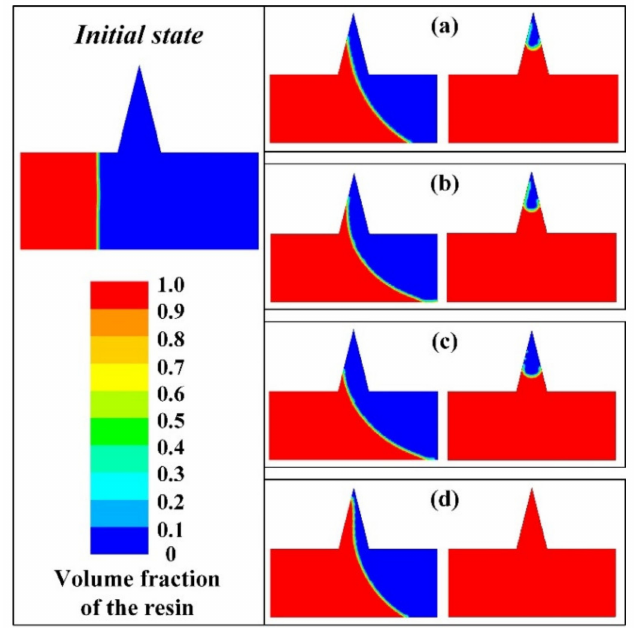
Figure 12. The filling evolution process with different slip positions ( a ) no-slip on both the mold and the substrate ( b ) slip on both the mold and the substrate ( c ) slip on the substrate only ( d ) slip on the mold only.